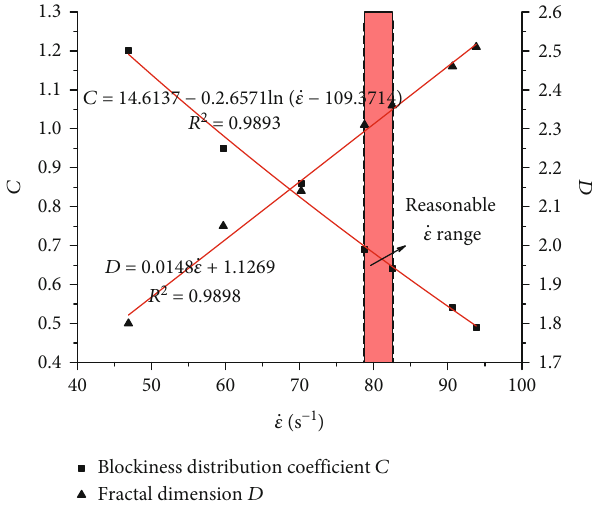
Figure 10: Relationship diagram for determining the range of reasonable strain